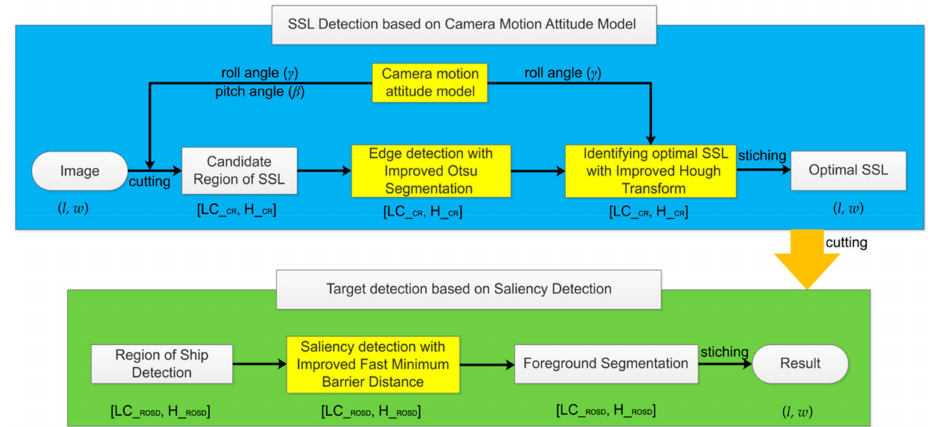
Figure 1. Technical framework of this paper. Roll angle ( γ ) and pitch angle ( β ) represent inertial data, ( l, w ) represents the size of the original image. [LC_CR, H_CR] represents the candidate (CR) of the image, where LC_CR represents the upper left corner of the CR, and H_CR represents the height of the CR. [LC_ROSD, H_ROSD] represents the region of ship detection (ROSD) of the image, where LC_ROSD represents the upper left corner of the ROSD, and H_ROSD represents the height of the